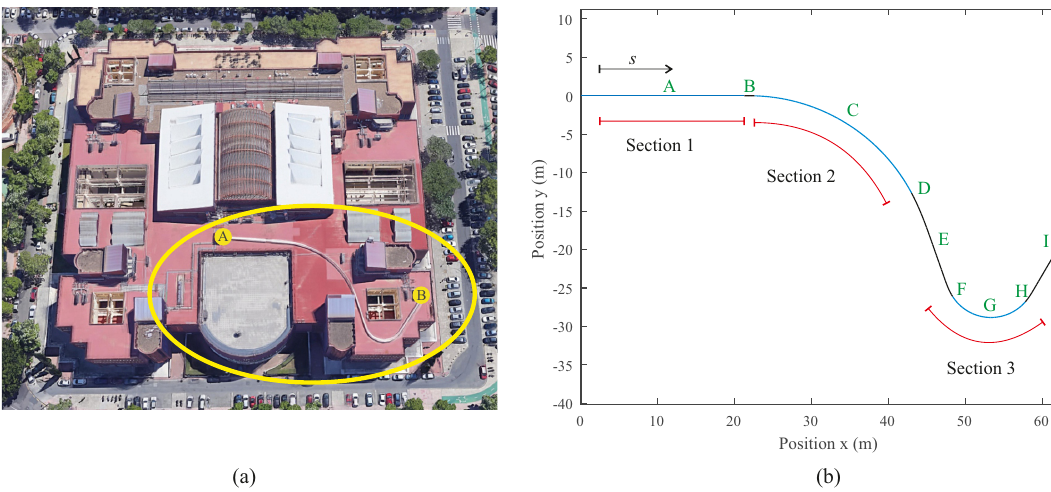
Figure 3. Separate views of the scaled track: aerial photograph ( a ) and sketch of the track centre line ( b